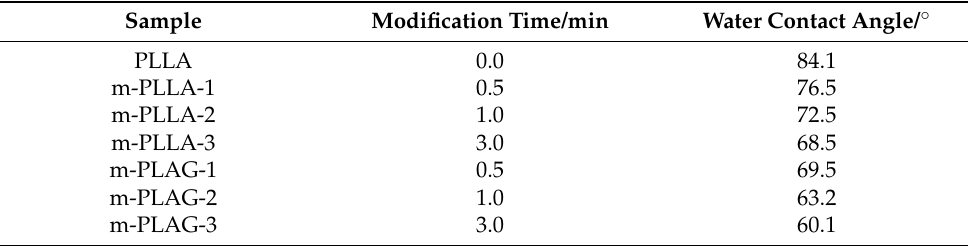
Figure 8. Water contact angle photographs of PLLA and modified films. ( a ) PLLA; ( b ) m-PLLA-1; ( c ) m-PLLA-2; ( d ) m-PLLA-3; ( e ) m-PLAG-1; ( f ) m-PLAG-2; ( g ) m-PLAG-3. Table 4. Water contact angle parameters of PLLA and modified films.